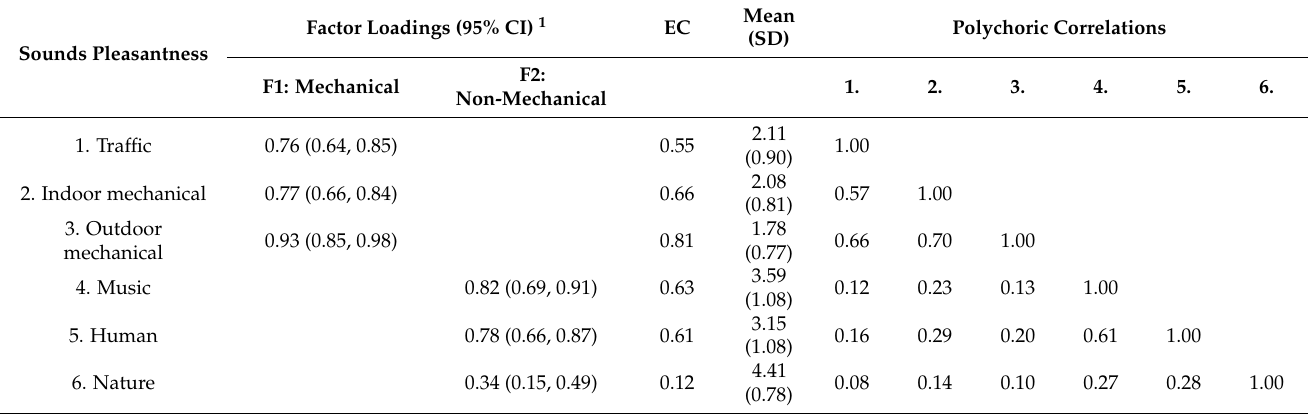
Table 2. Statistics for the sounds pleasantness items in the two-factor exploratory factor analysis rotated solution.